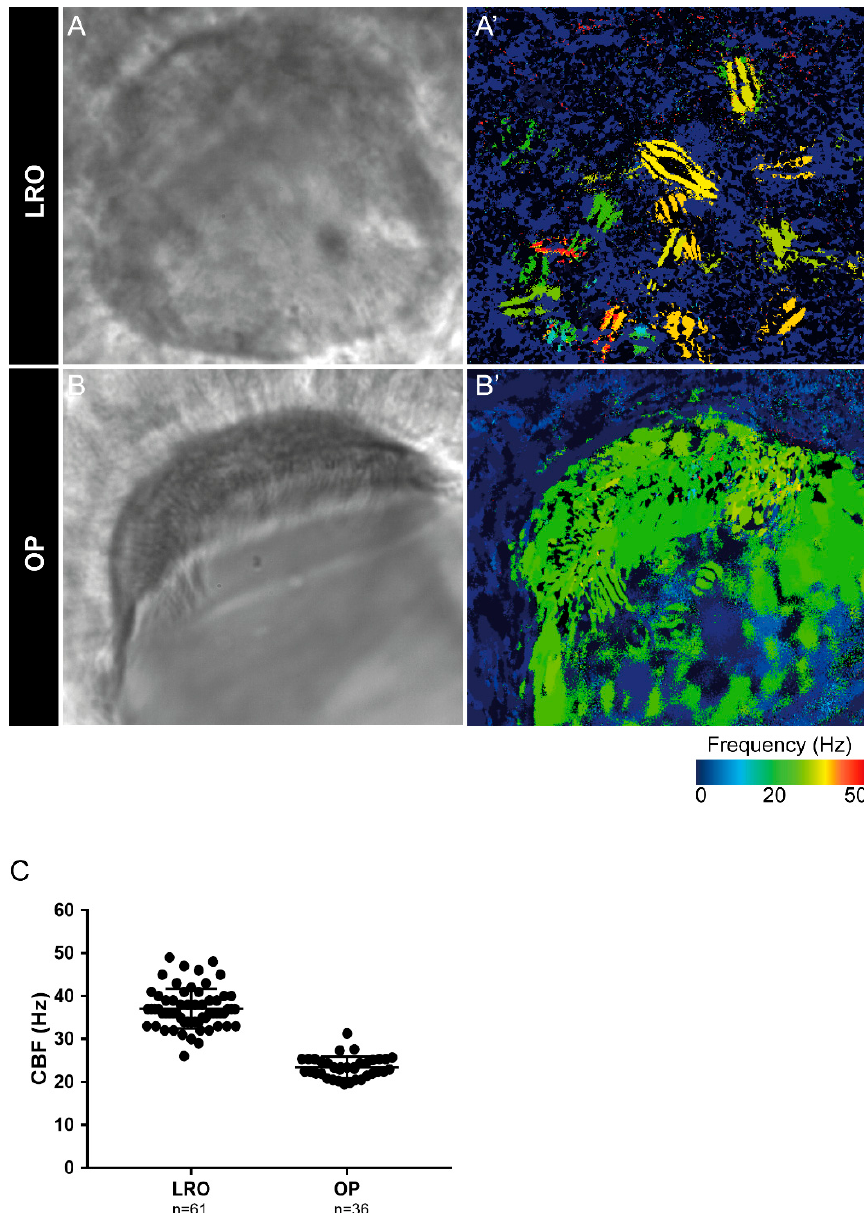
Figure 3. Cilia beat frequency (CBF) evaluation for zebrafish cilia. ( A , A’ ) Full LRO heatmap showing several monocilia at one plane beating at different frequencies (20–50 Hz). ( B , B’ ) OP heatmap showing multiciliated cells with cilia beating at more homogeneous frequencies (around 20 Hz). CBF was measured using the software CiliarMove [41] ( C ) Quantification of CBF from n = 61 LROs and n = 36 OPs from embryos at 10 ss and 4 dpf larvae, respectively.